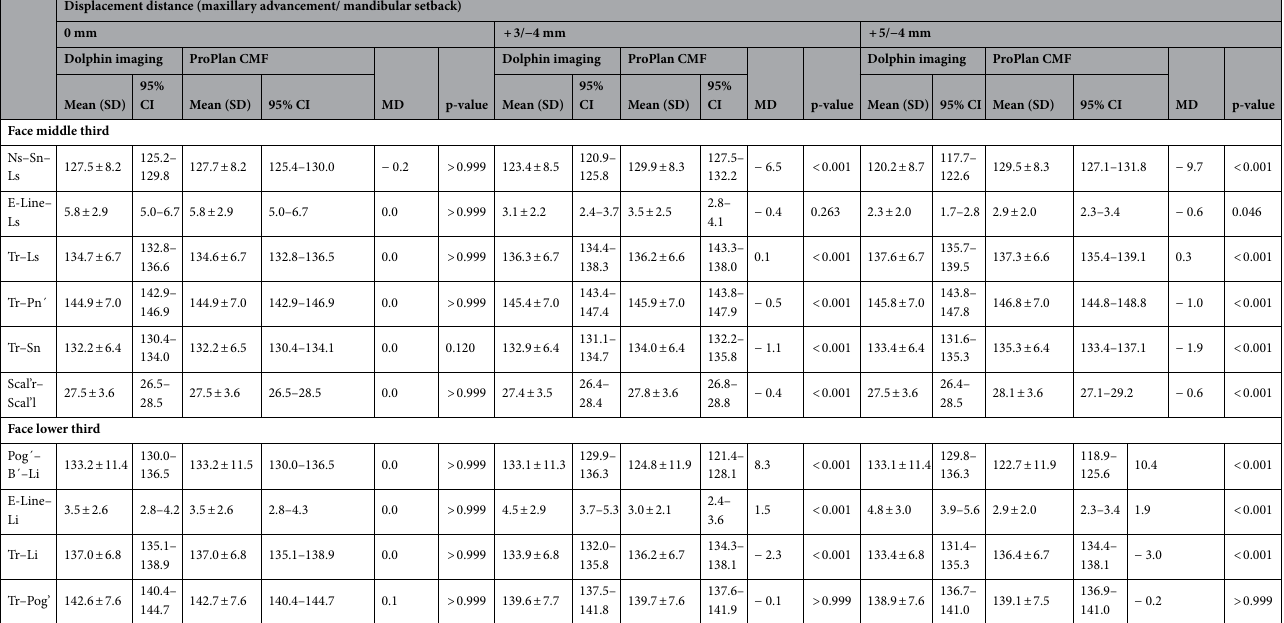
Table 8. Mean values, SDs and 95% confidence intervals of the angular and linear changes in the middle and lower third of the face after bi-maxillary surgery simulation with the corresponding p-values of the comparison between the outcome of the surgical planning program Dolphin and ProPlan depending on the different displacement distances for maxillary advancement ( +) and mandibular setback (−). SD standard deviation, n.s. not significant, CI confidence interval, MD mean